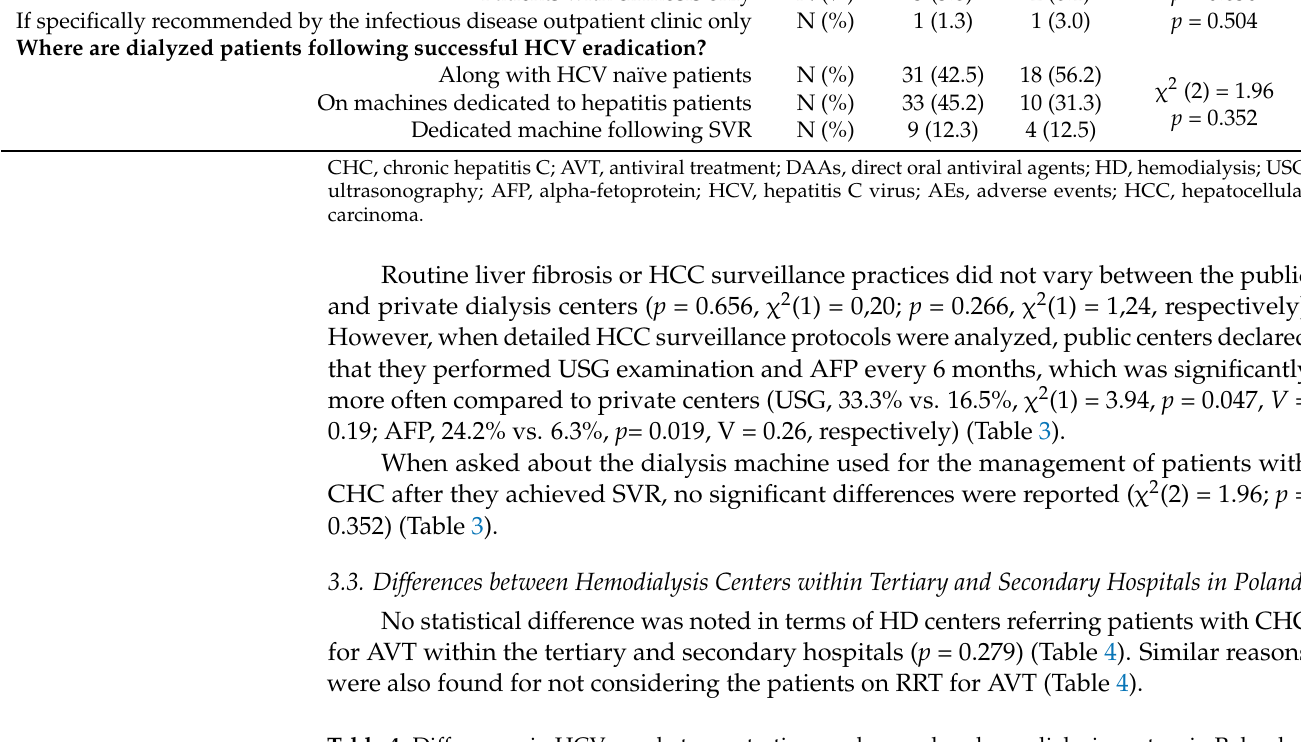
Table 4. Differences in HCV care between tertiary and secondary hemodialysis centers in